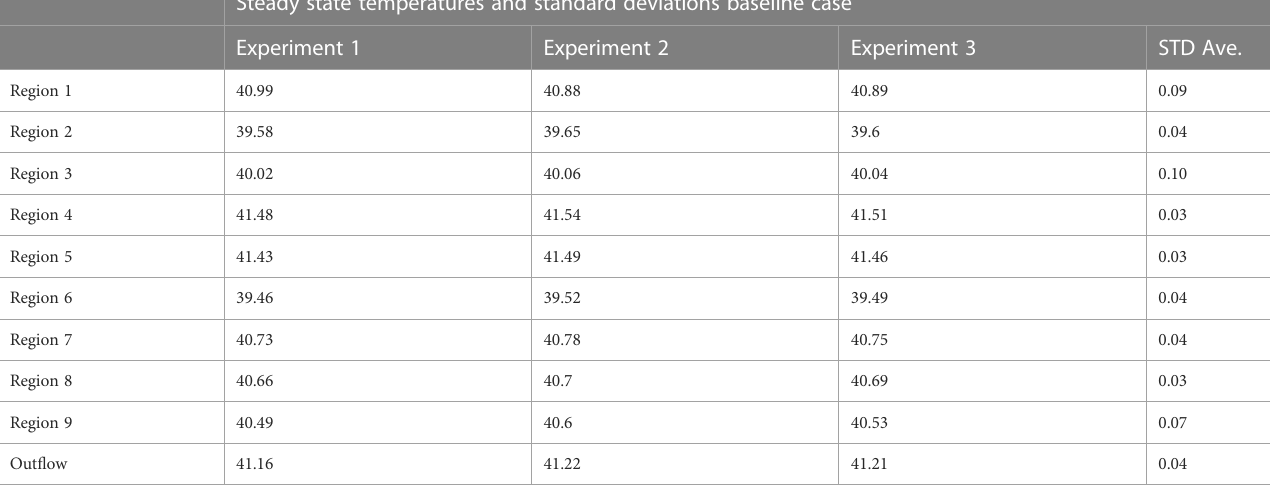
TABLE 3 Steady state temperatures and standard deviations baseline case.